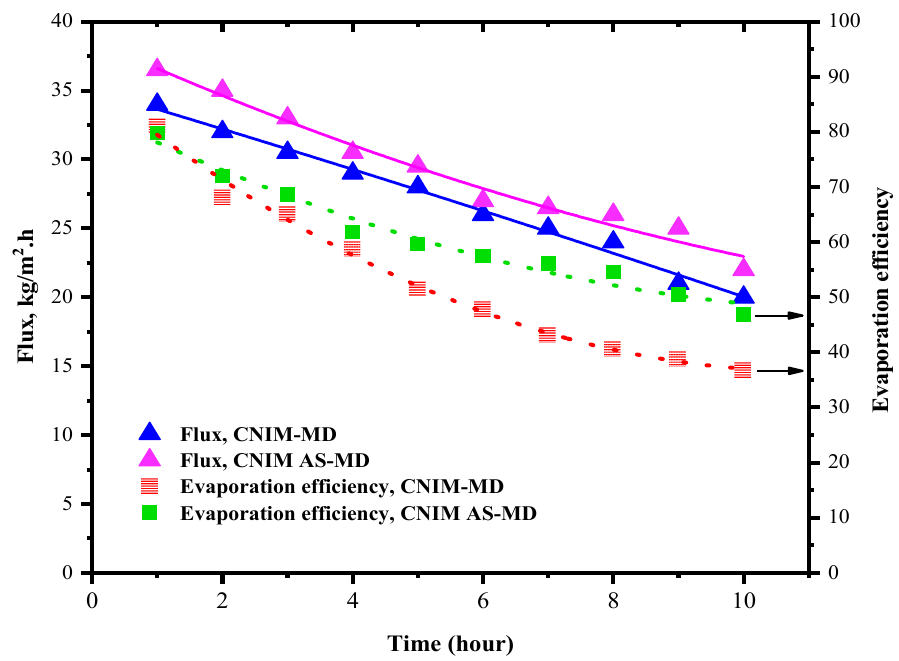
Figure 5. Flux and evaporation efficiency of 100 mg/L HA solution on CNIM membrane.